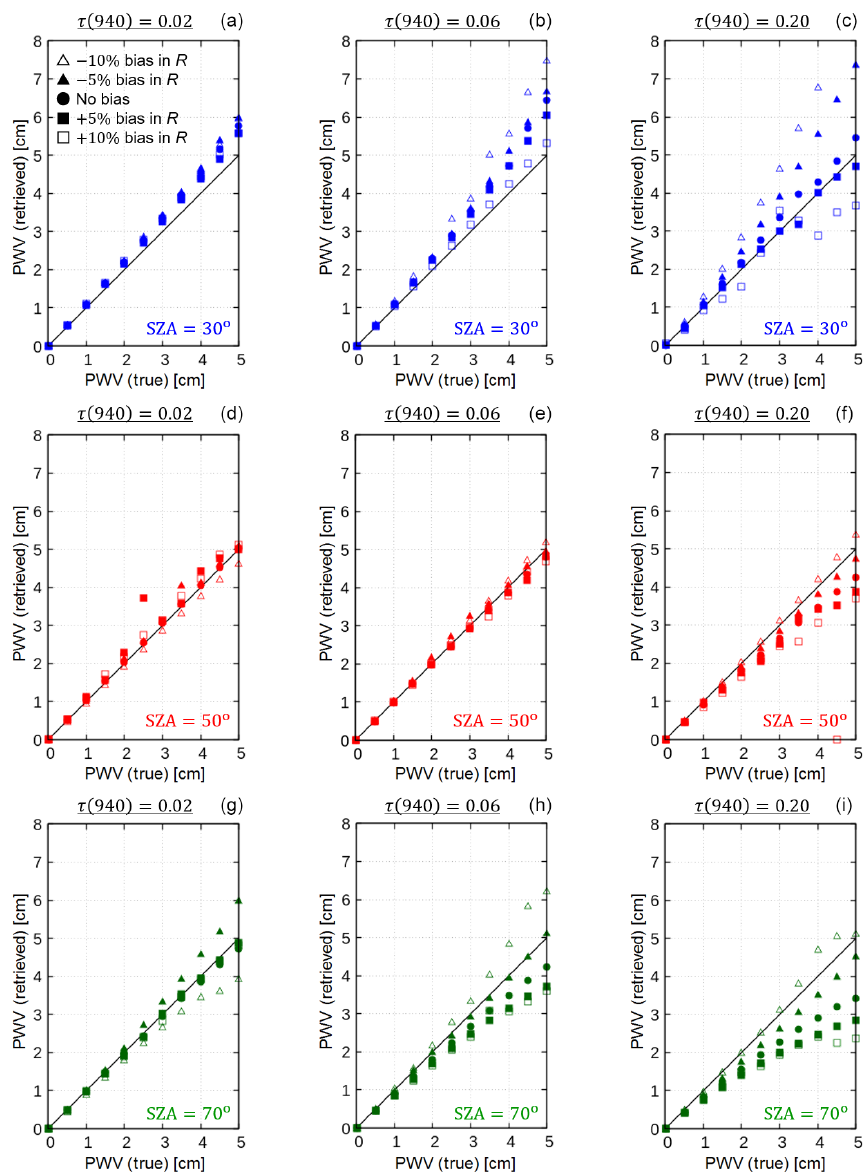
Figure 14. Similar to Fig. 13 but for transported-dust